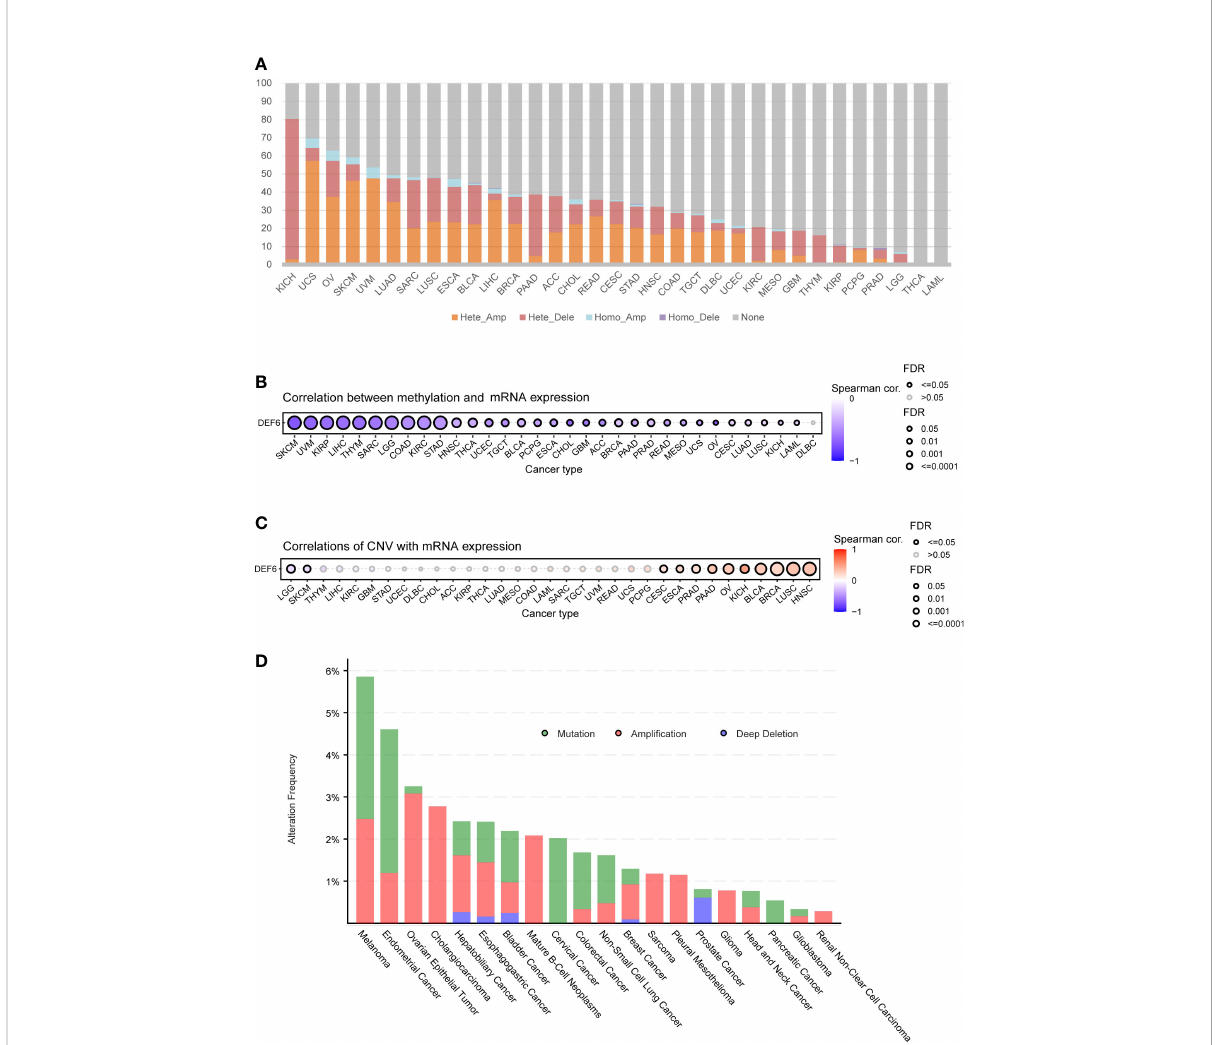
FIGURE 6 DEF6 and genetic alteration pro fi les. (A) The bar plot summarizes the CNV of DEF6 in a variety of cancers. (B, C) The correlation between methylation and CNV with DEF6 mRNA expression. (D) DEF6 alteration frequencies in various cancers. p -values are adjusted by the FDR method. CNV, copy number